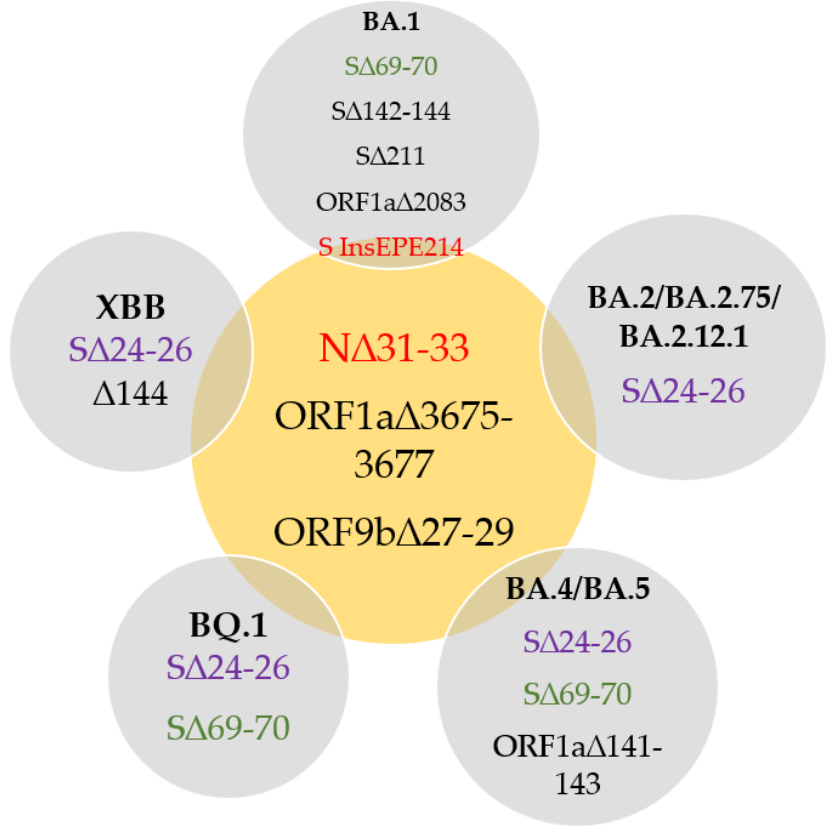
Figure 3. Diagram of the deletions shared by Omicron subvariants.